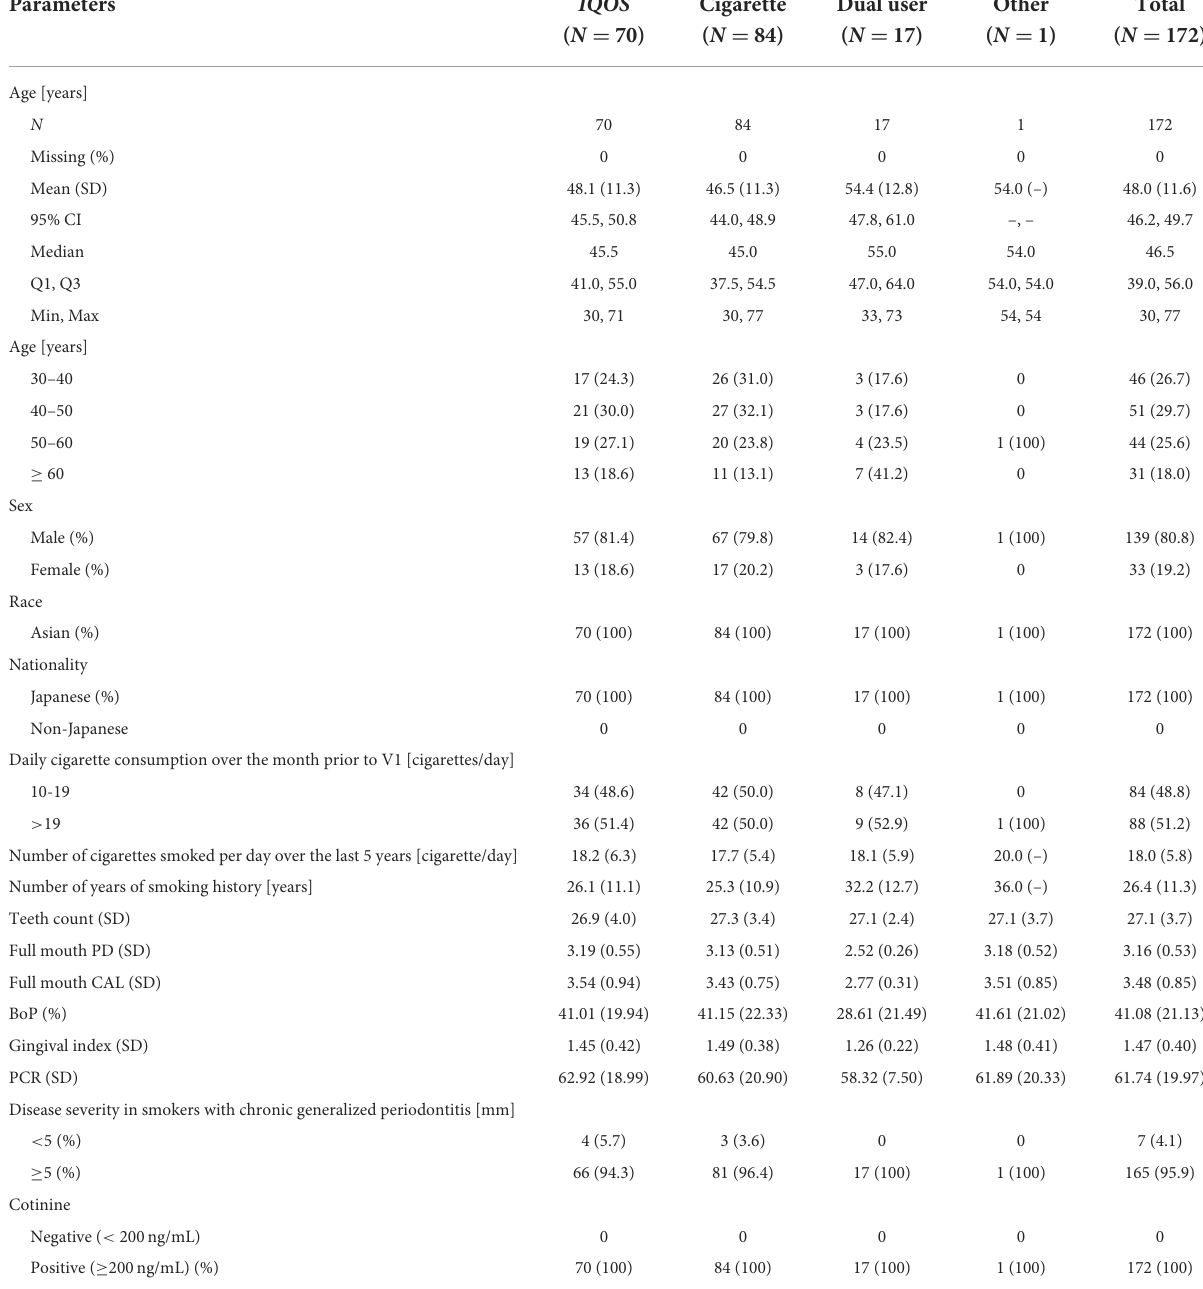
TABLE 1 Summary of participants’ demographic characteristics by product-use category in the As Exposed